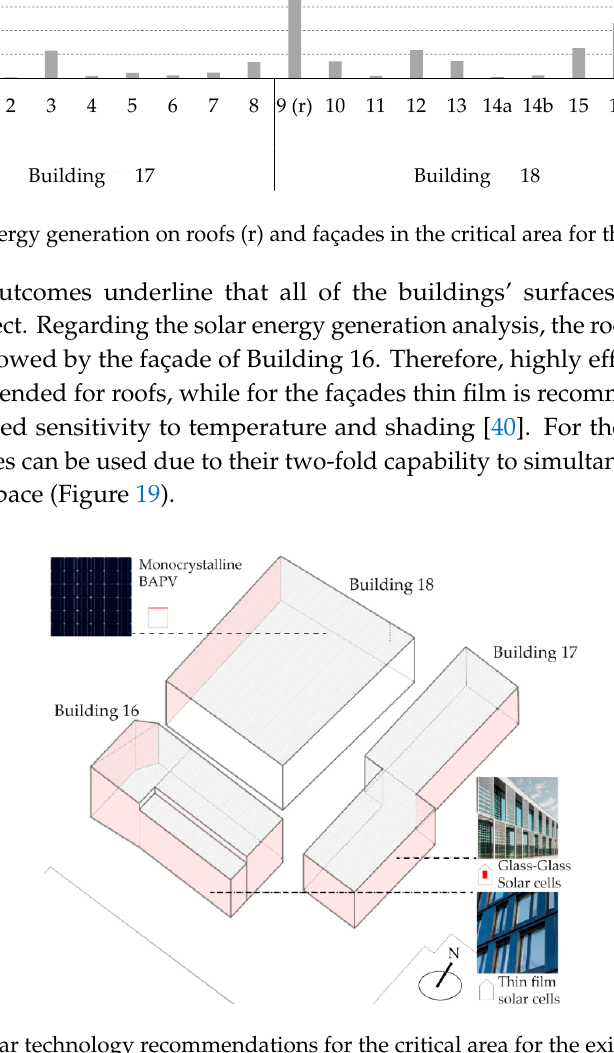
Figure 20. Annual analysis of direct solar irradiation ( a ) and global irradiation ( b ) in the critical area for feasibility study I. The analysis in the critical area shows that the highest energy generation is from façades oriented southwest (Building 2 and Building 7), which are mainly unshaded by other buildings, while the pitched roof on Building 15b oriented southwest has the highest solar energy production, reaching 21,800 kWh/year.